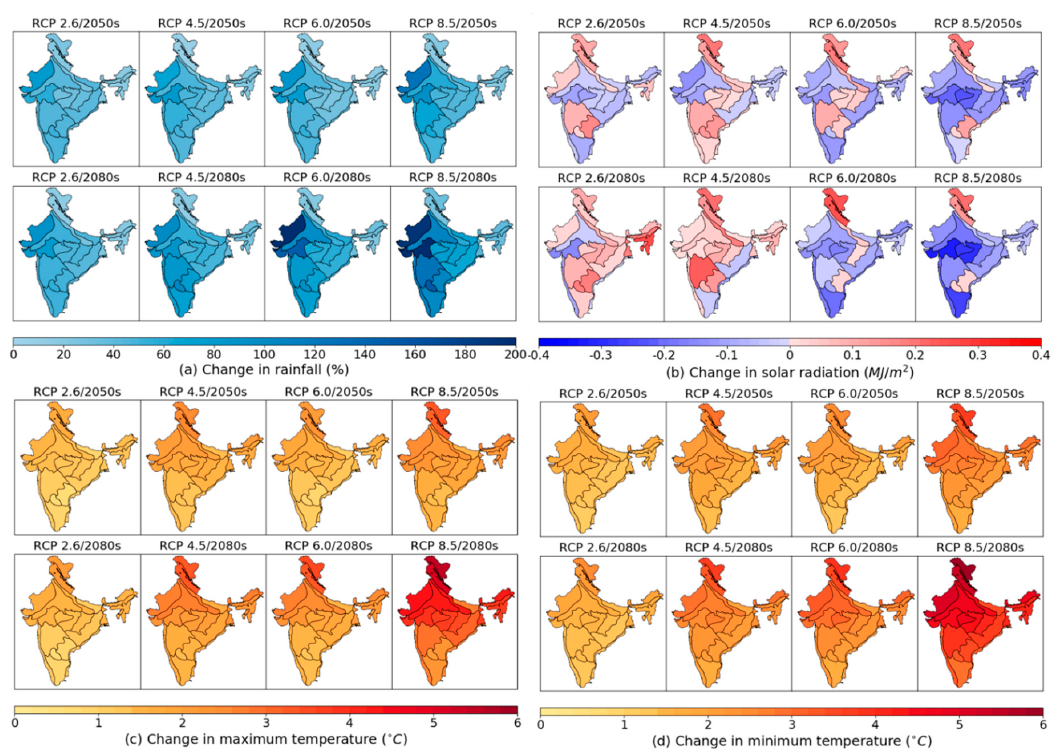
Figure 8. Climate change analyzed based on mean changes during winter (October–March) in ( a ) rainfall, ( b ) solar radiation, ( c ) maximum, and ( d ) minimum temperature with respect to 1990s for two future periods—2050s and 2080s and all the RCP scenarios.